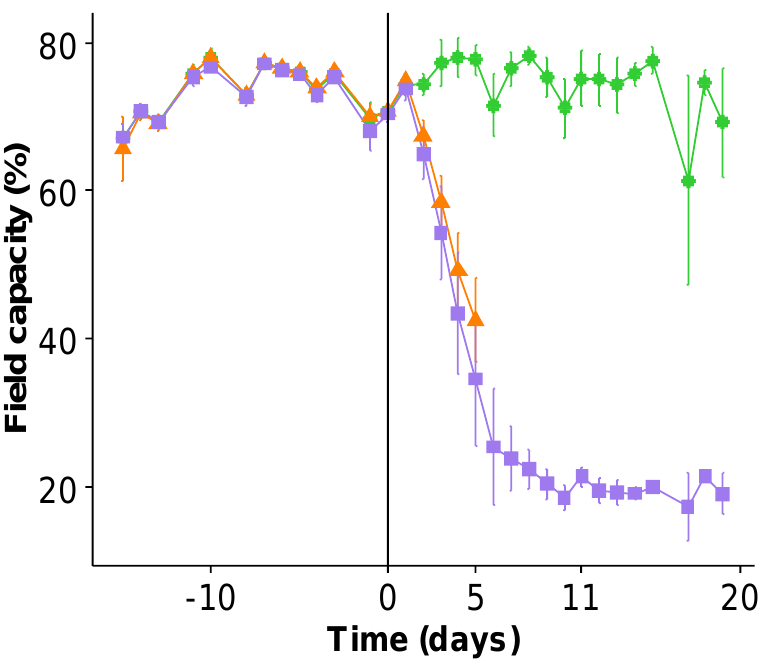
Figure 2. Soil water content was expressed as a percentage of field capacity (FC) during the experi- ment. After sowing, plants were kept at 80% FC for thirty days (until 0 d). Thereafter, well-watered control plants were kept at 80% FC until the end of the experiment, while watering was stopped at 0 d until the FC of all water deficit (WD) pots dropped to 40% FC (5 d) and then 25% FC (11 d). Consequently, from 11 d to 20 d, WD pots were held at 25% FC by automatic watering. Soil water contents, as well as the amount of water to be supplied, were automatically assessed with the high throughput phenotyping platform during the experiment, and each value corresponds to the lowest soil water content recorded daily or twice a